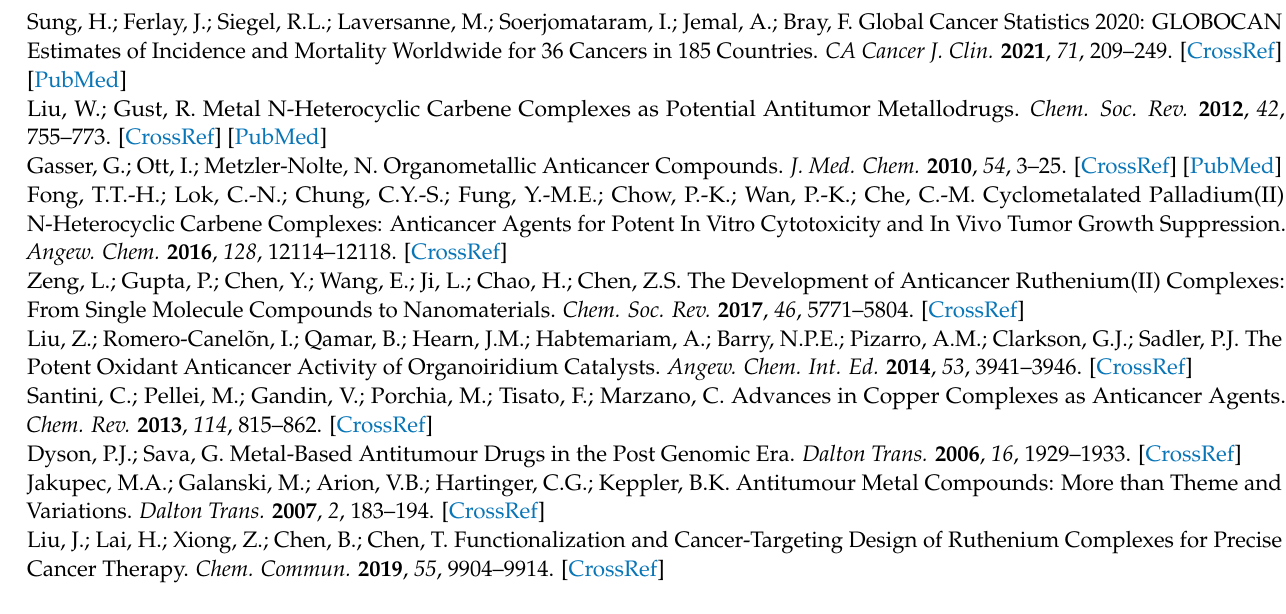
Figure S12: Van’t Hoff plots quenching for (A) {HSA-[Ru( η 5 -C 5 H 5 )(mTPPMS)(bopy)][CF 3 SO 3 ]} and (B) {HSA faf -[Ru( η 5 -C 5 H 5 )(mTPPMS)(bopy)][CF 3 SO 3 ]}